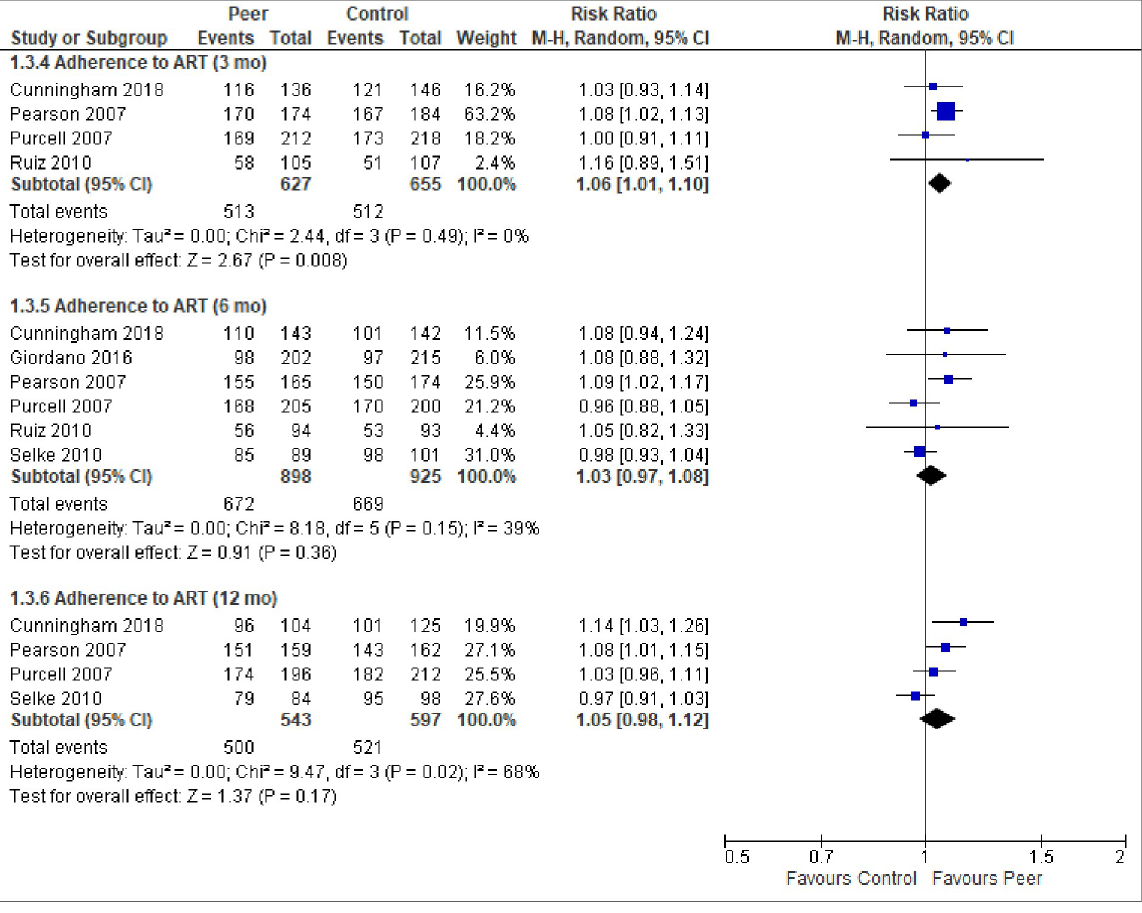
Fig 5. Meta-analyses of outcome adherence to ART.